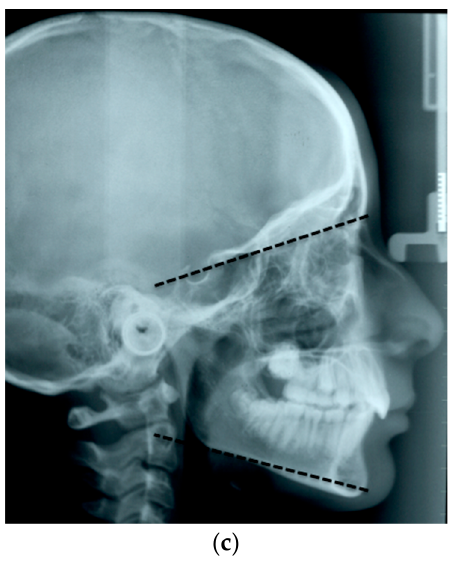
Figure 2. ( a , b ) Hypodivergent and hyperdivergent patients according to SN^GoGn; and ( c ) Normodivergent patient according to SN^GoGn.